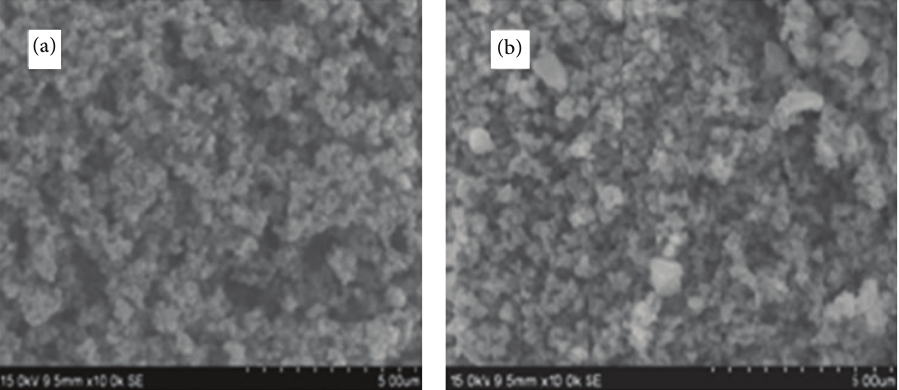
Figure 3: SEM analysis of TiO 2 (a) and TiO 2 -Ce (b) doped catalyst.